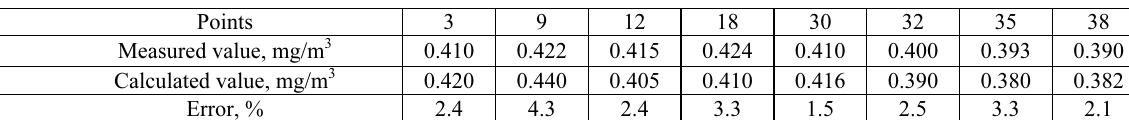
Fig. 3. Results of SP dispersion simulation for July 11, 2005 (during “out-of-rush” hours) in Žvėrynas district area Table 3. Comparison of experimental results (of July 11, 2005) and theoretical ones